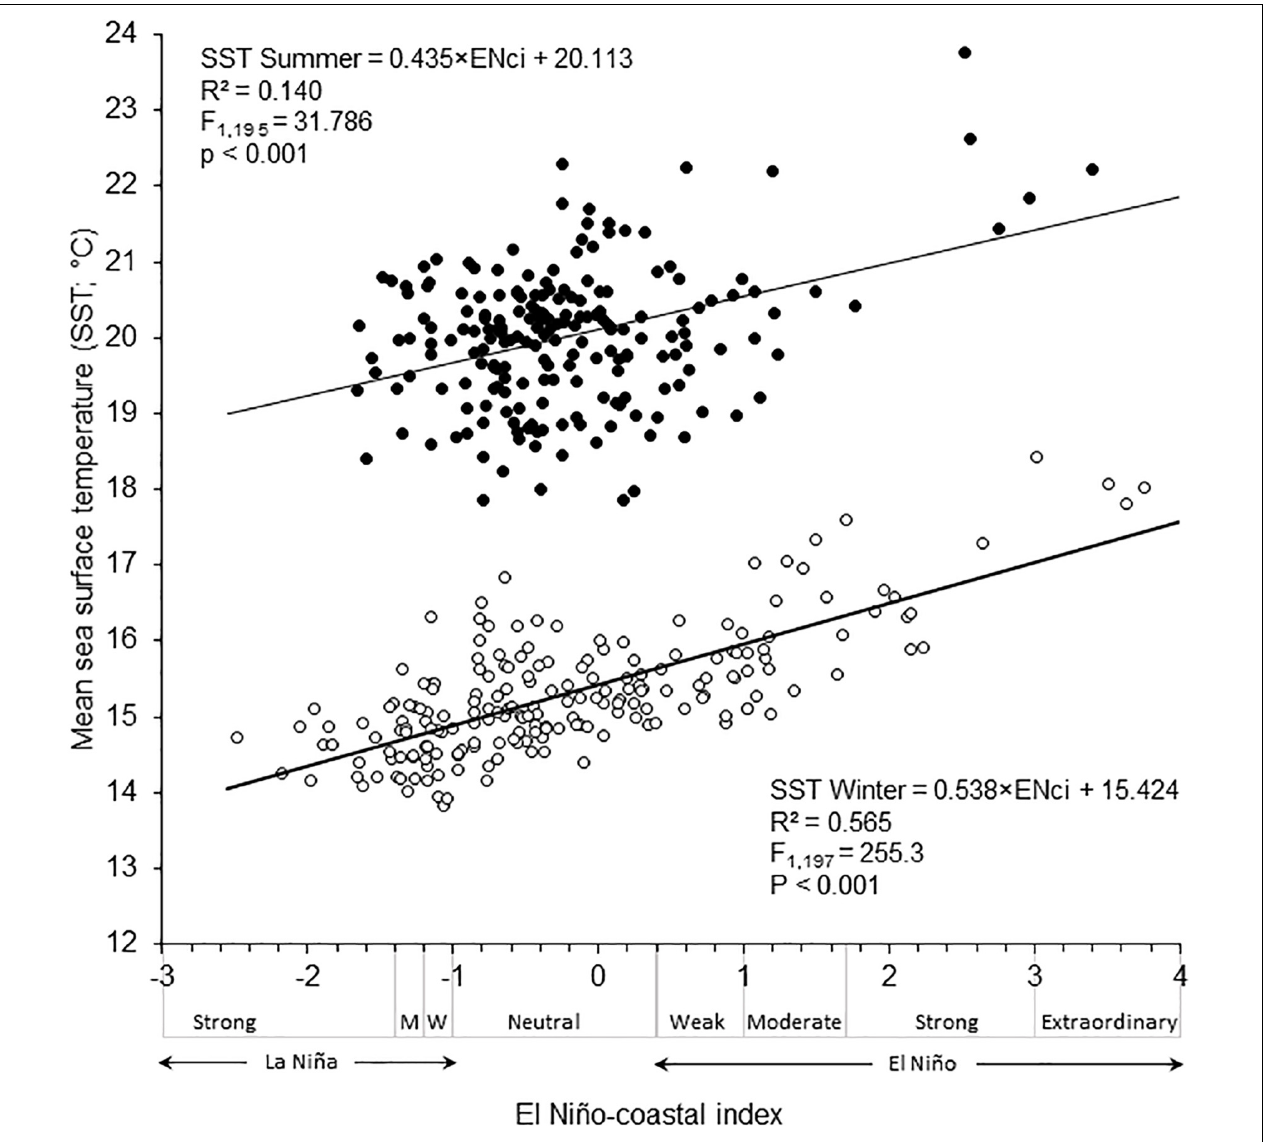
FIGURE 3 | The relationship between El Niño-La Niña episodes, as described by El Niño-Coastal Index, and summer and winter SST in Antofagasta Bay between February 1950 and December 2017. Classification of el Niño-La Niña episodes according to Takahashi et al.